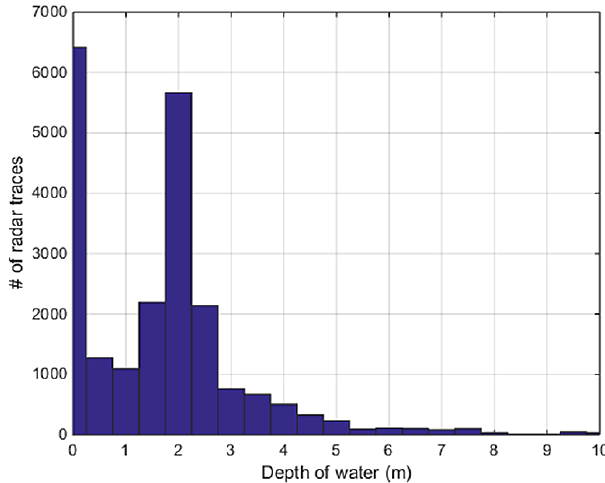
Figure 8. Histogram showing the depth of the water surface from every radar return over a buried lake from 2009 to 2012. Error esti- mates on the depth are on average 9% shallower due to uncertainties associated with the stratigraphy of density across the GrIS, which is used to convert radar travel time to